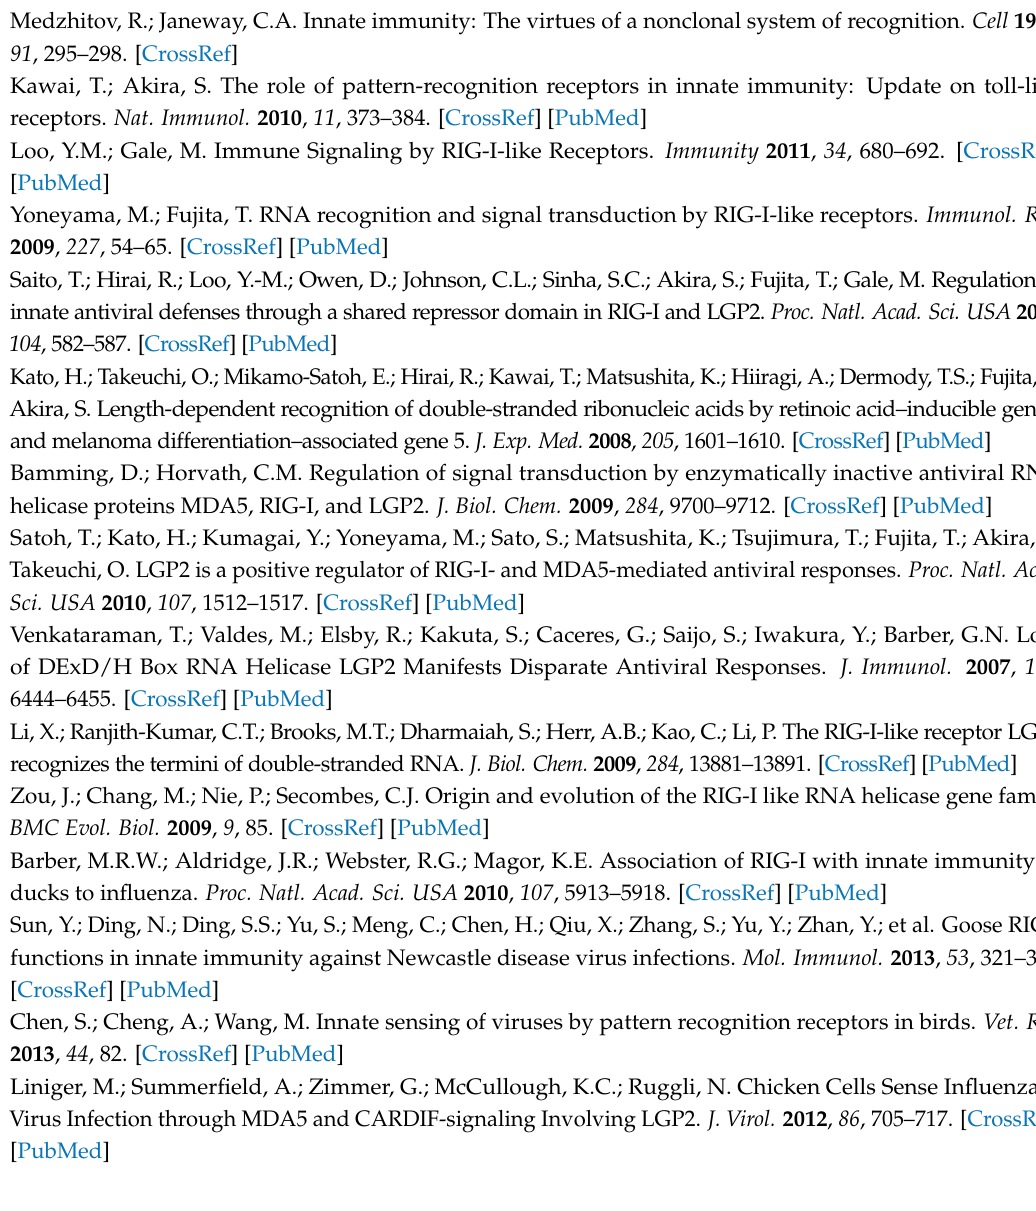
Table S1: Datasets of RLR CDSs, Figure S1: Six-class face quality assessment of the predicted avian RLR CDSs, Figure S2: Phylogeny of the species used for comparative analyses of RLRs between birds and mammals (dataset 3), Figure S3: dN/dS of the three avian RLRs compared with average level of coding genes in birds, Figure S4: BSR analysis of avian